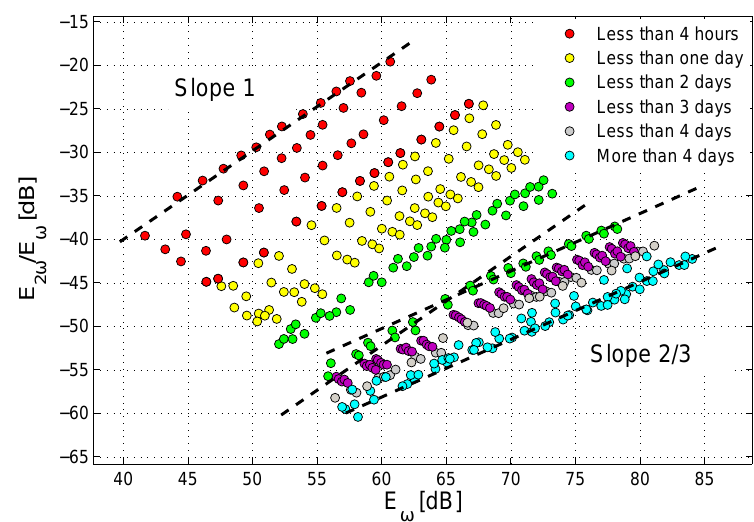
Figure 7. E NL = E 2 ω / E ω versus E ω for variable-amplitude sine excitations as a function of healing time for Specimen No.